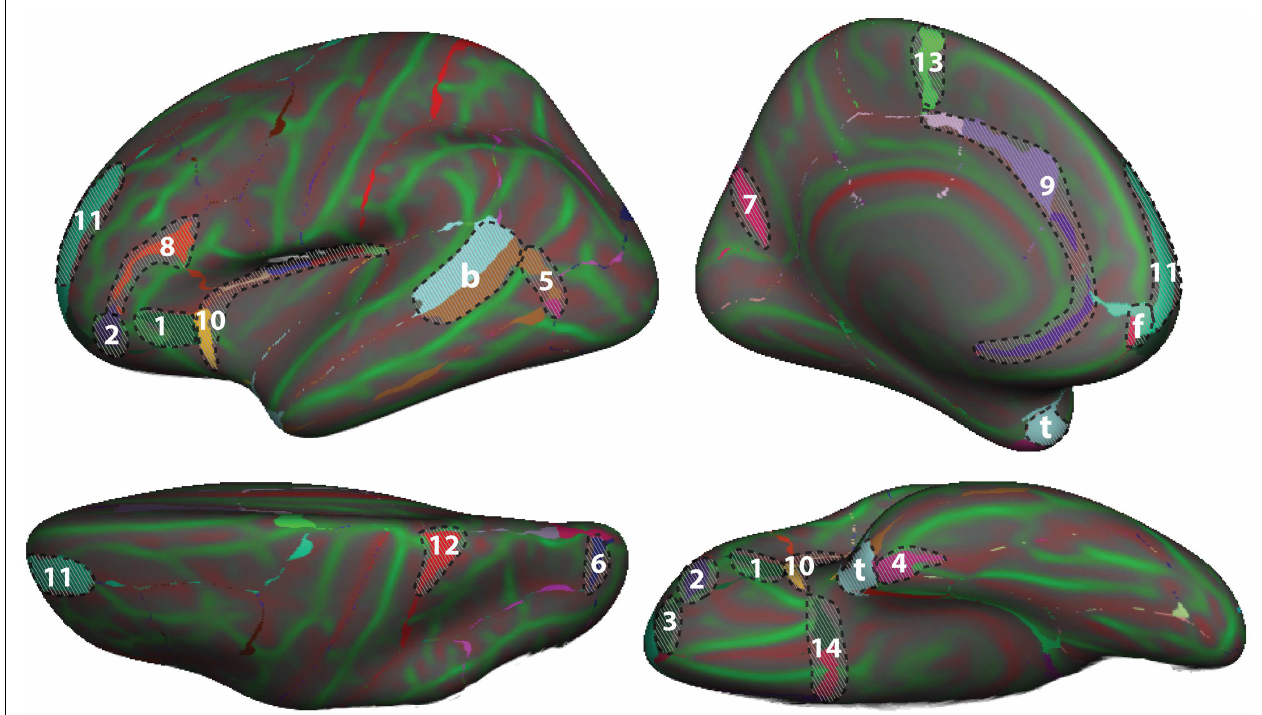
boundaries, particularly for the medial (1) and anterior (2) borders of pars orbitalis , the anterior border of the lateral orbitofrontal region (3), the lateral border of entorhinal cortex (4), and the anterior boundary of lateral orbital gyrus (5), and the posterior boundary of the superior parietal region (6); ii, variability of the bounding landmarks, particularly for the fundus of the parietooccipital sulcus (7) and the inferior frontal sulcus (8); iii, variation in the interpretation of landmarks, particularly for the cingulate sulcus (9), dorso-rostral portion of the circular sulcus (10), the rostral portion of superior frontal sulcus (11), the dorsal portion of the postcentral sulcus (12), the paracentral sulcus (13), and the posterior boundary of the medial and lateral orbitofrontal regions (14), and iv, variation in the training data set that was used to construct the classifier.The medial surface view was rotated from the parasagittal plane to expose the temporal